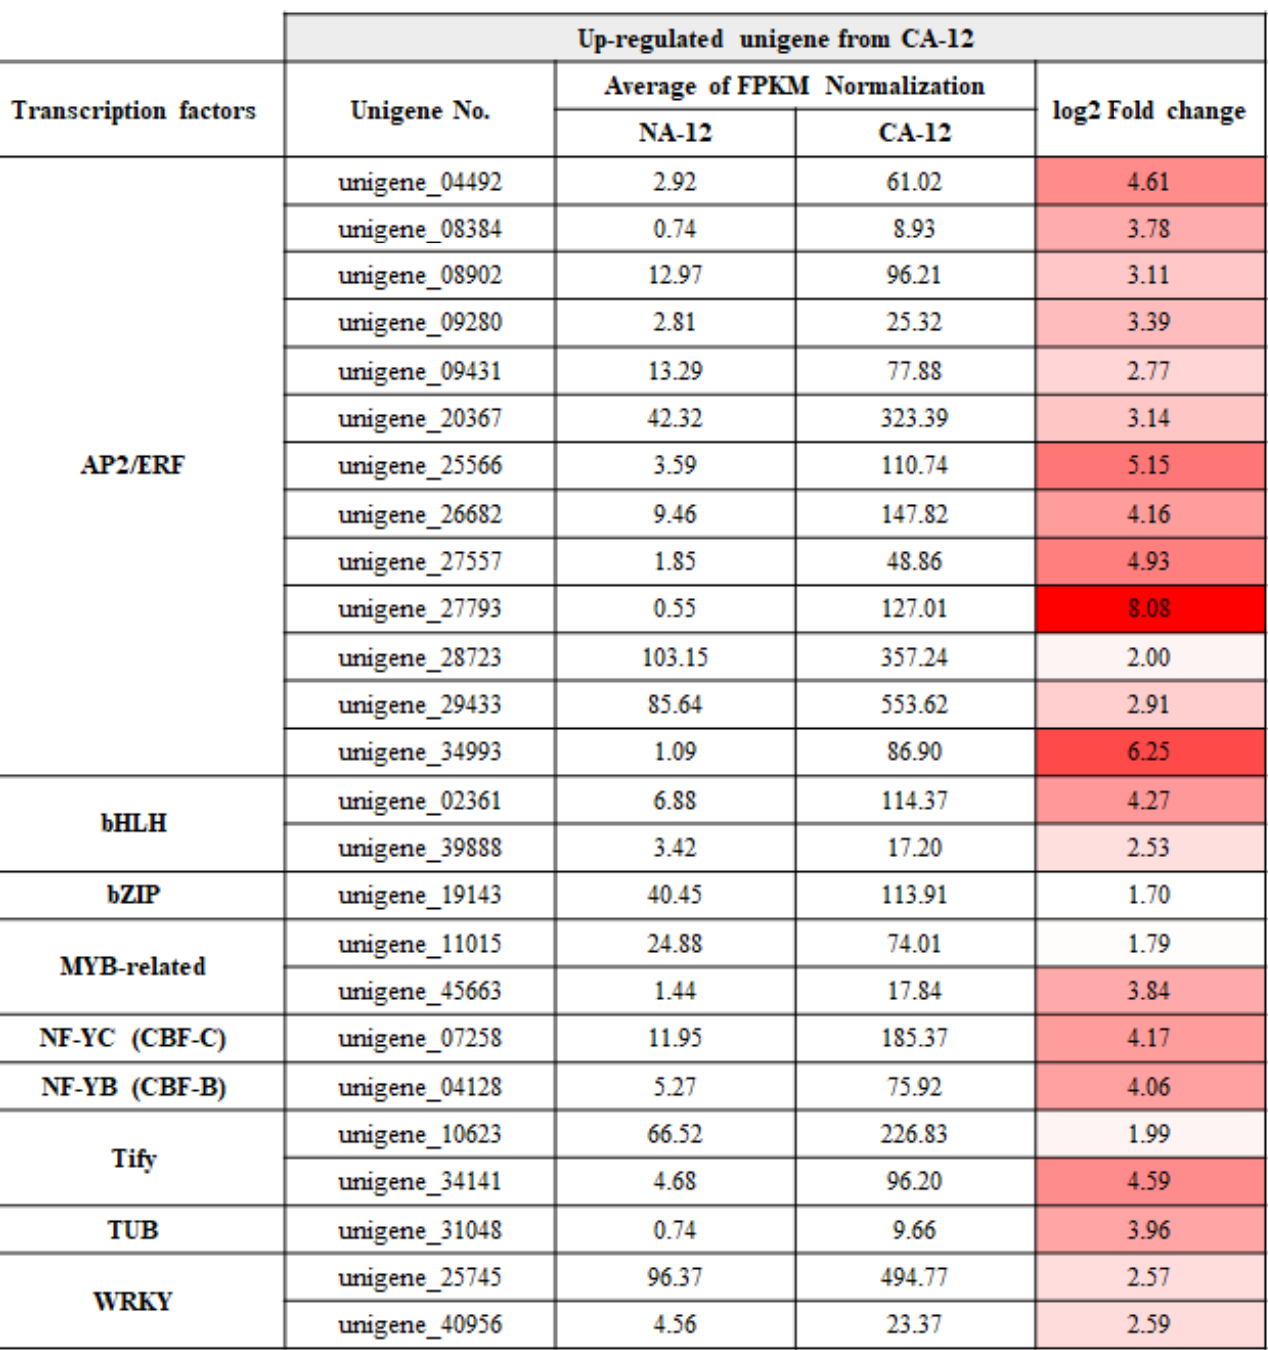
Figure 5. List of up-regulated unigenes encoding transcription factors in the CA-12 treatment. The average FPKM normalization and log 2 fold change values for the identified 25 unigenes are described. In the log 2 fold change column, red indicates the highest value, and white indicates the lowest value. CA-12, A. turgidum protonema were cold-acclimated at 4 °C for 2 days and exposed to freezing until − 12 °C; NA-12, A. turgidum protonema were non-acclimated at 25 °C for 2 days and exposed to freezing until − 12 °C.